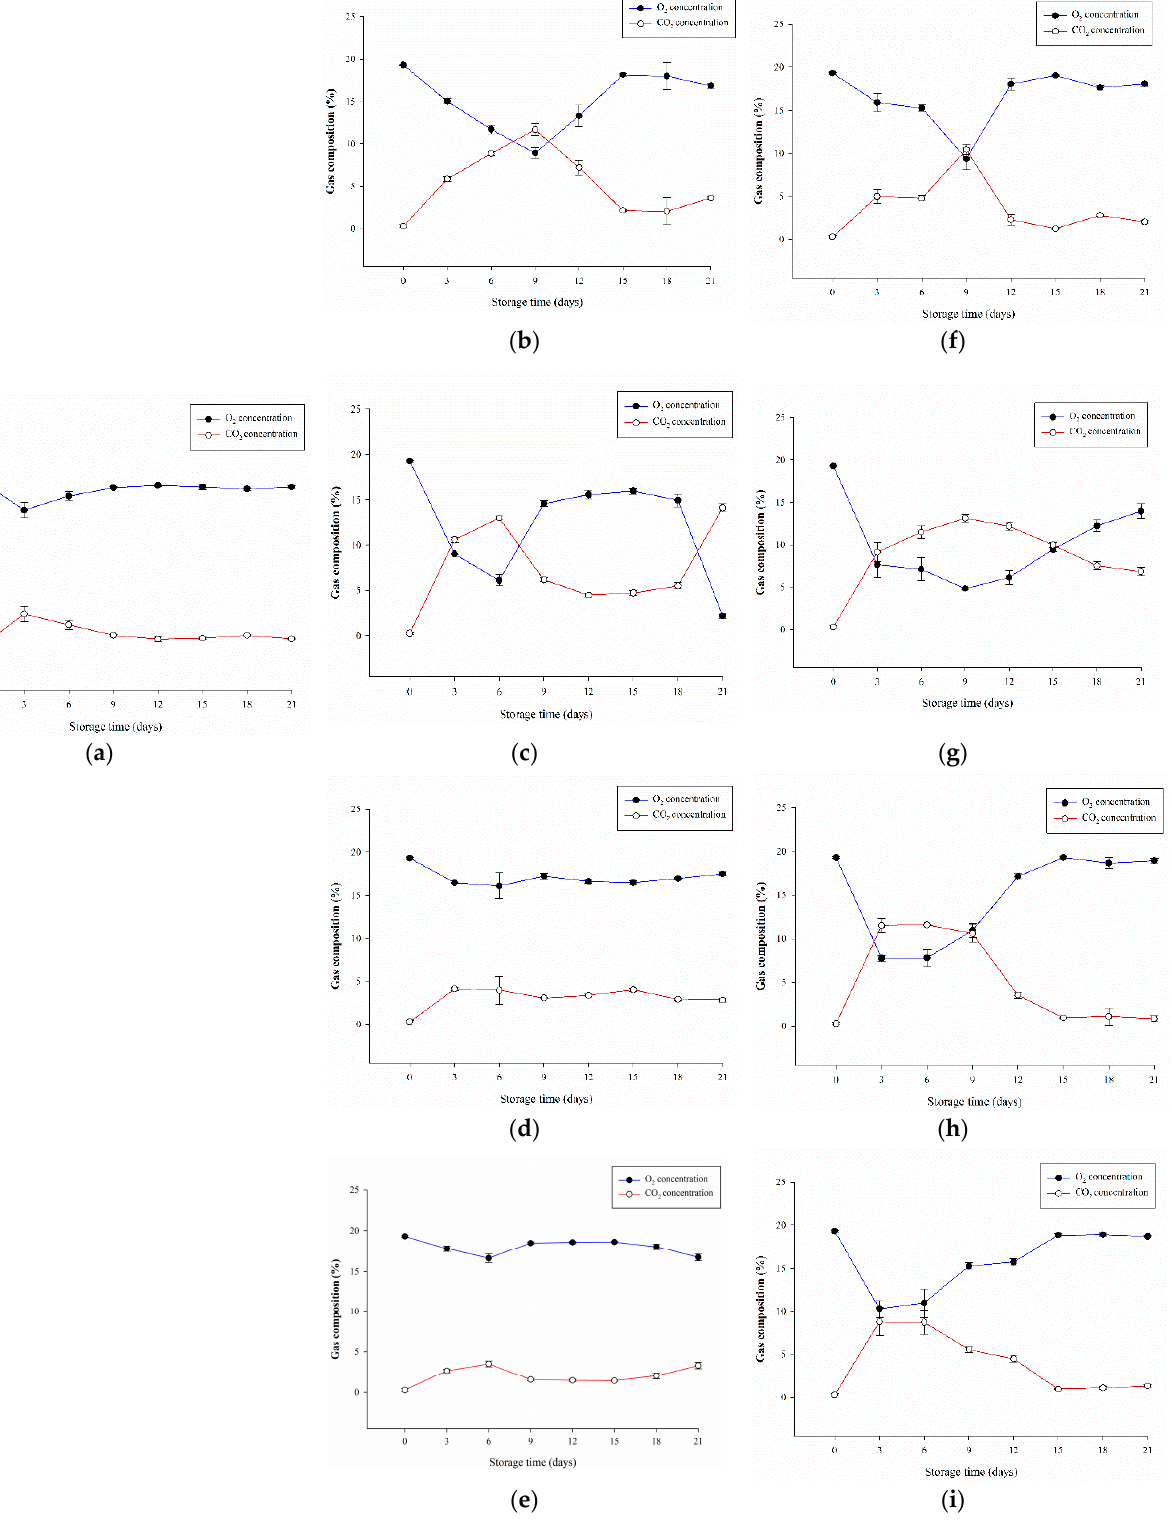
Figure 6. The effects of different packaging films on respiration of A. bisporus stored at 4 °C after 21 days. ( a ) Control. ( b ) P-0.5CMC. ( c ) P-1.0CMC. ( d ) P-3.0CMC. ( e ) P-5.0CMC. ( f ) P-0.5COL. ( g ) P-1.0COL. ( h ) P-3.0COL. ( i ) P-5.0COL. a–e Means followed by different superscripts indicate the statistically significant different values among treatments at the same storage time ( p <